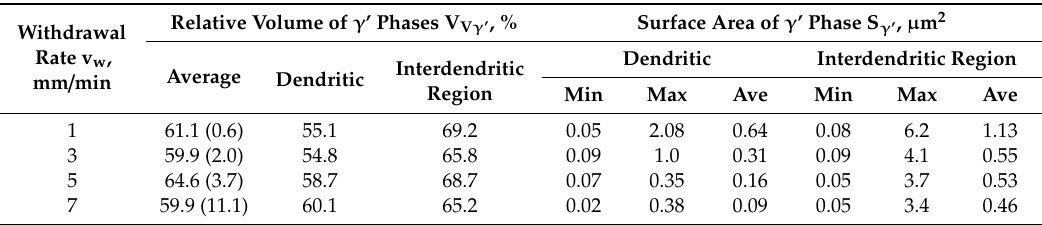
Table 2. Volume fraction and surface area of γ ’ phase precipitates in CMSX-4 superalloy in the as-cast state, depending on the rate of single crystal withdrawal.